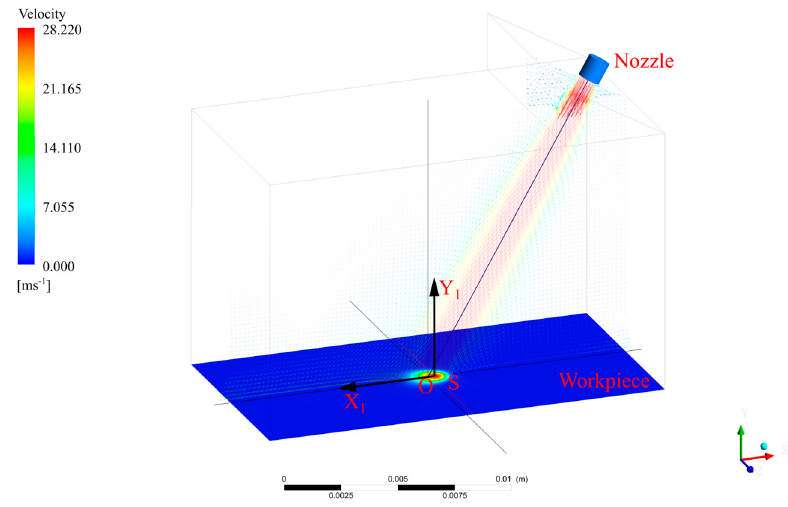
Figure 3. A schematic diagram of the FLUENT jet simulation structure.